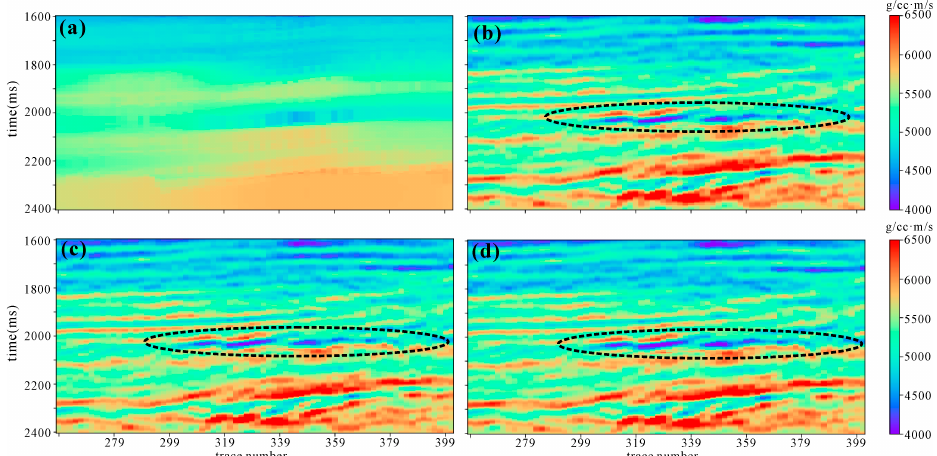
Figure 10. The 2D cross-section of inversion results: ( a ) prior mean model, ( b ) final posterior MAP model, ( c , d ) MAP models for 2 of 4900 realizations of wavelet and noise variance.